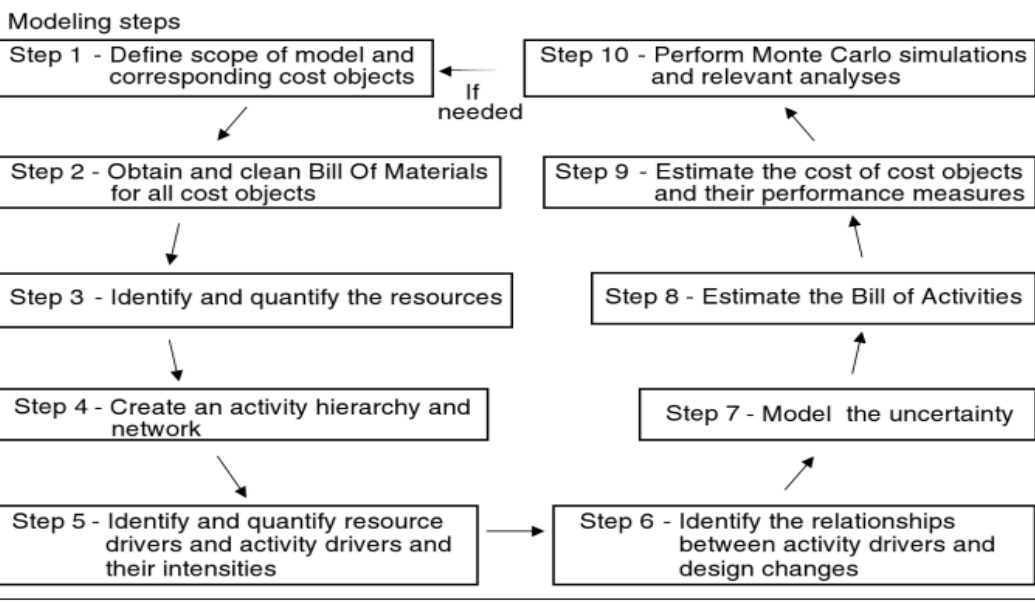
Source : Emblemsvag,